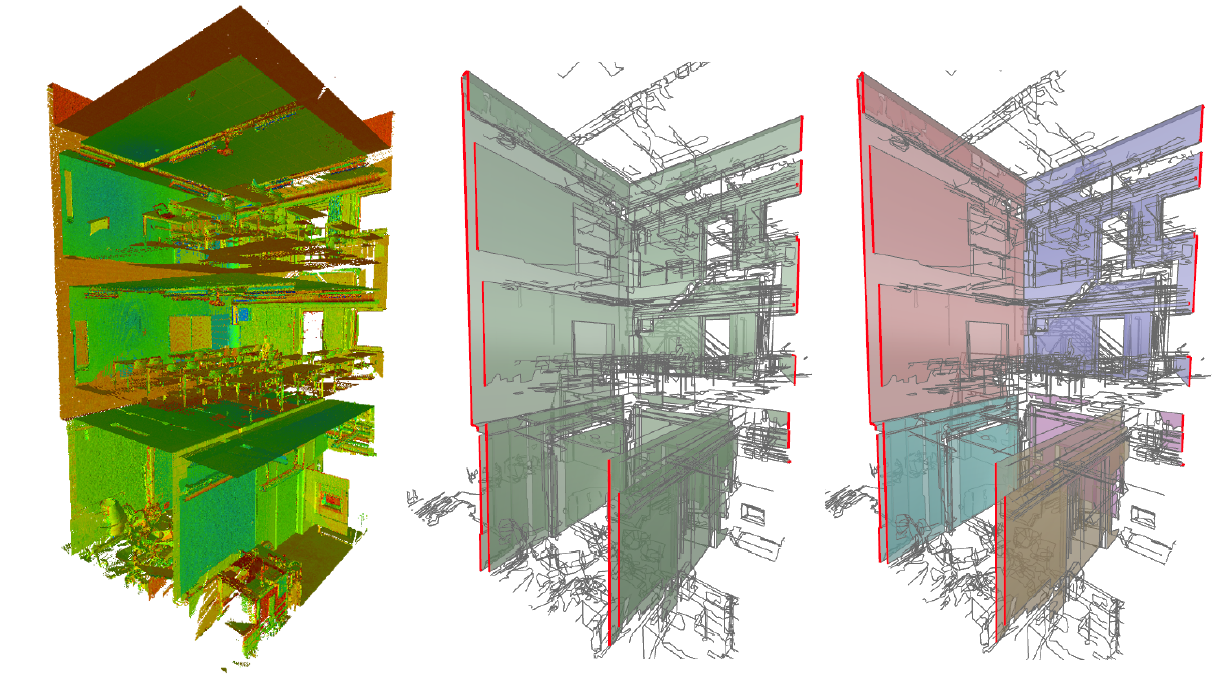
Figure 1: Overview of the different steps in the data association workflow: unstructured point cloud (left), extracted classified planar wall segments (mid) and the grouped wall observations per wall